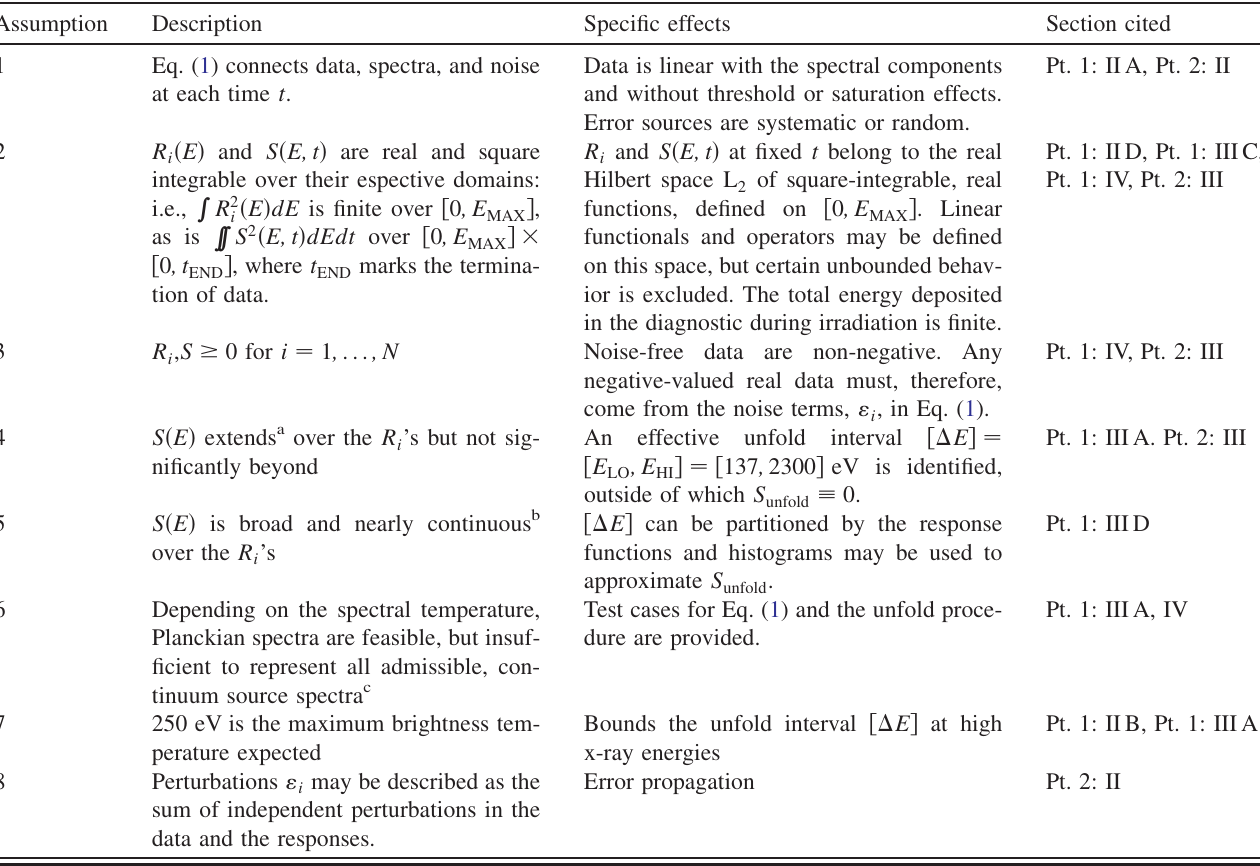
TABLE I. A priori information concerning source x-ray spectra and response functions for the filtered-XRD diagnostic at the Z